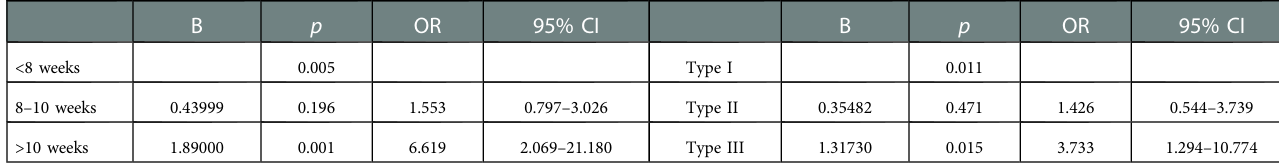
TABLE 3 Binary logistic regression for the prediction of signi fi cant intraoperative blood loss according to the gestational age and cesarean scar pregnancy type. B